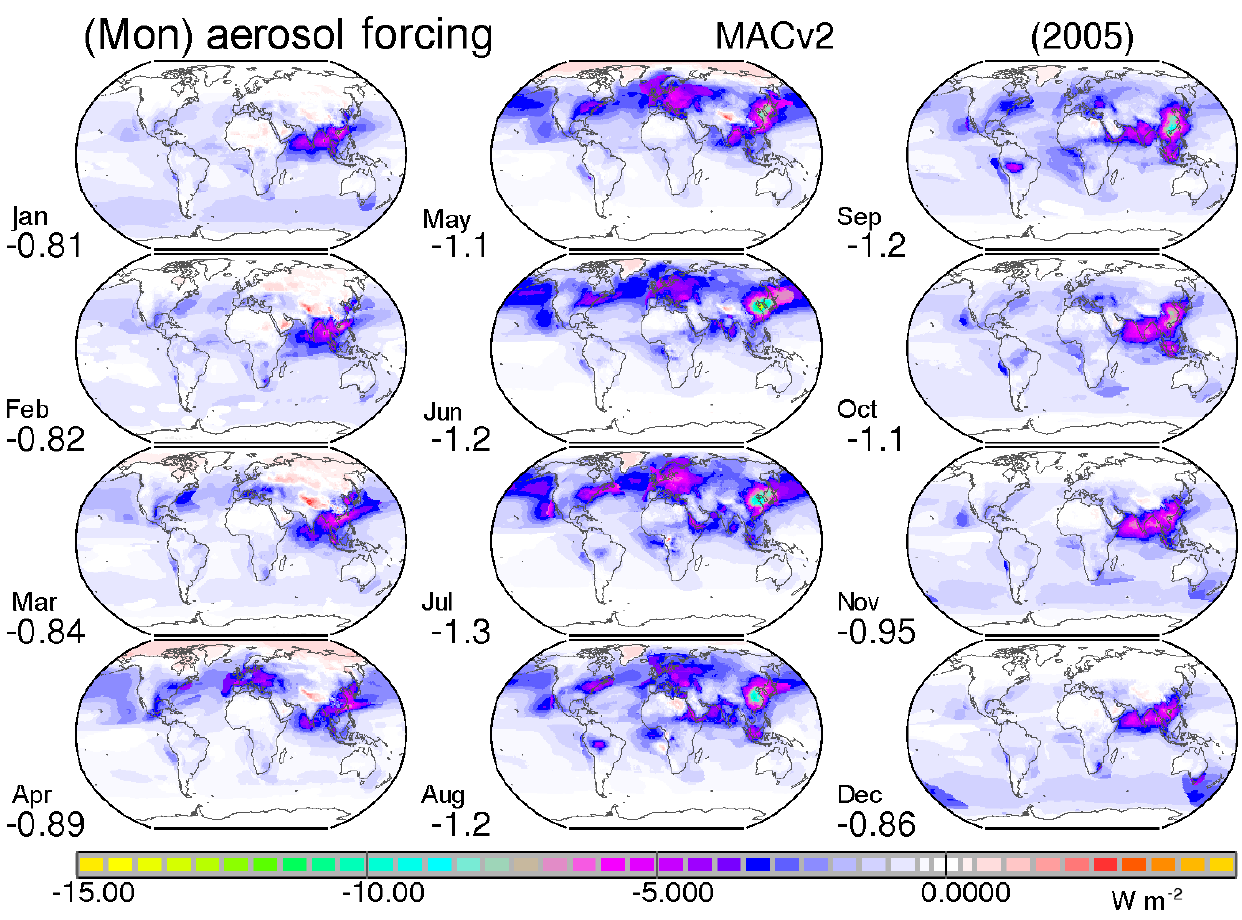
Figure 16. Monthly maps for today’s total forcing by present-day anthropogenic aerosol.